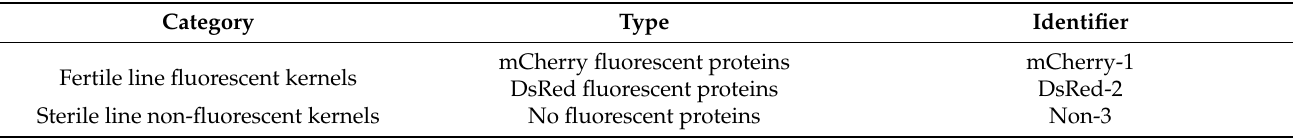
Figure 1. Three types of maize kernels based on the type of fluorescent protein: ( a ) mCherry (mCherry-1), ( b ) DsRed (DsRed-2), and ( c ) no fluorescent protein (Non-3). Table 1. Categories and types of maize kernel